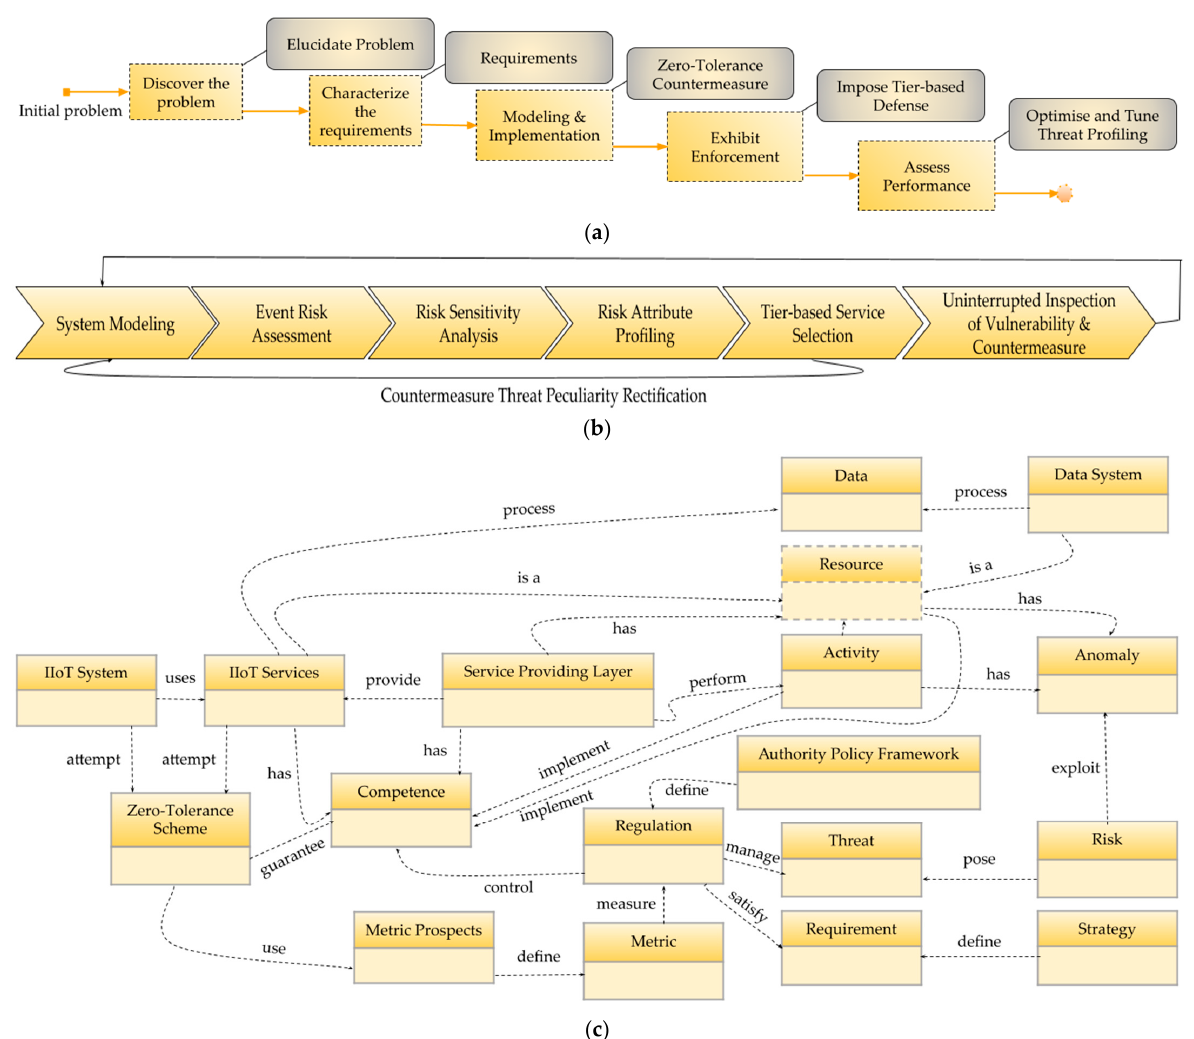
Figure 1. Leveraging Zero-Tolerance Security Framework. ( a ) Outline of the framework for design science study. ( b ) Uninterrupted Perceptible Risk Management. ( c ) Model integration.